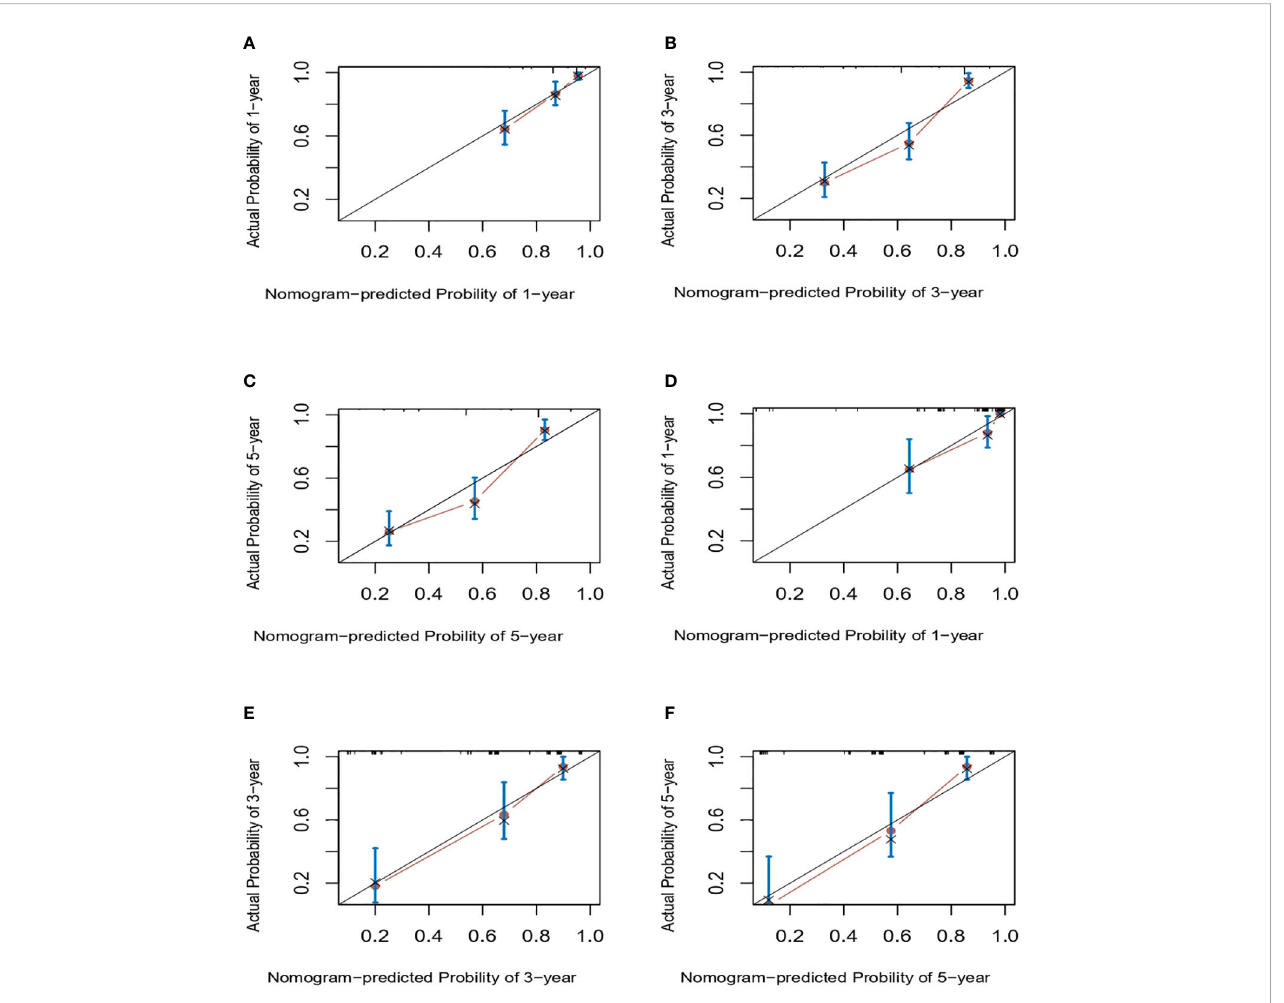
FIGURE 4 Calibration curves for predicting IGBC OS at 1-, 3-, 5-year in the training (A – C) and validation set (C – E) , respectively. IGBC, incidentally gallbladder cancer; OS, overall